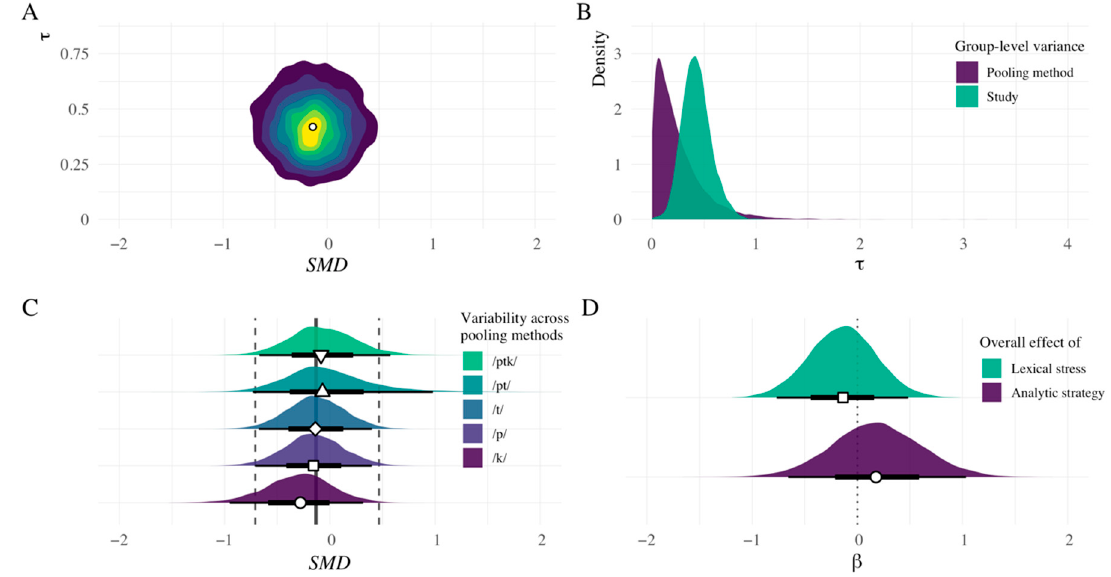
Figure 1. Summary of the posterior distribution of the meta-analytic model. Panel ( A ) plots the pooled estimate of effect size (SMD) on the horizontal axis and standard error ( τ ) on the vertical axis. Lighter colors illustrate higher density areas (i.e., more plausible values) and the point represents the posterior median. Panel ( B ) illustrates estimates of variance from group-level effects and Panel ( C ) provides a sub-category summary of variability as a function of pooling method. The vertical lines show the posterior median (solid) and 95% credible interval (dashed) of the pooled effect. Panel ( D ) summarizes the posterior distributions of the overall effects of the lexical stress and analytic strategy moderators.